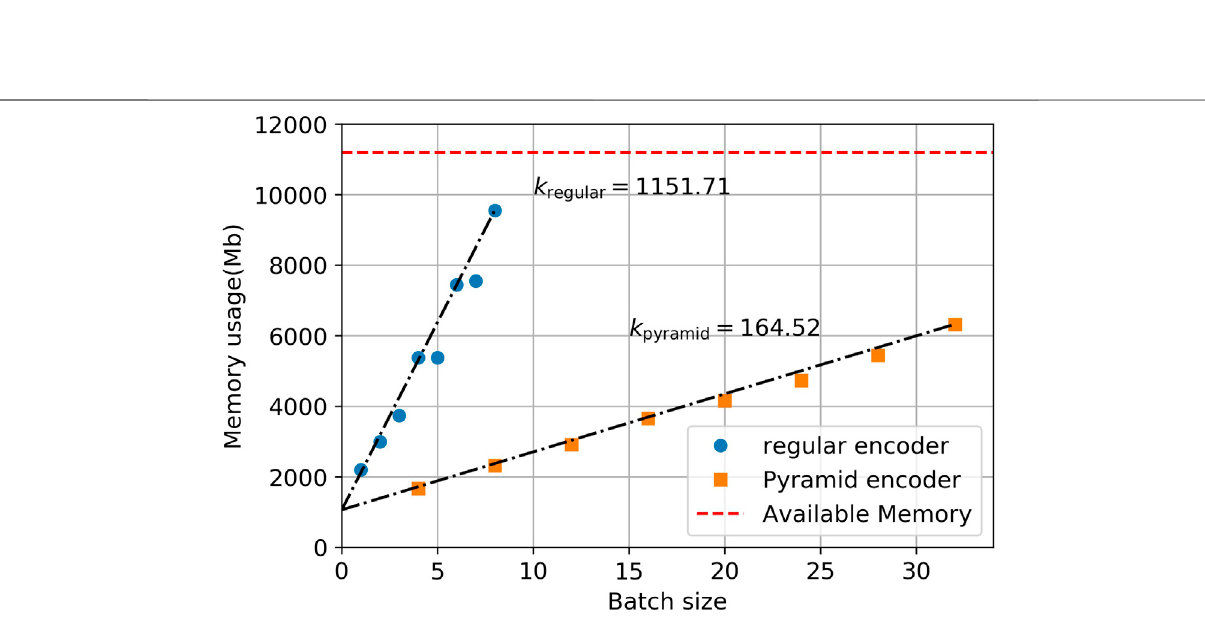
FIGURE 5 | Memory cost per instance for GRU models with Bahdanau attention, k is calculated by fi nding the slope of the linear fi t (black dashed line). The red dashed line represents the maximum memory of a GeForce GTX 1080 Ti graphic card.